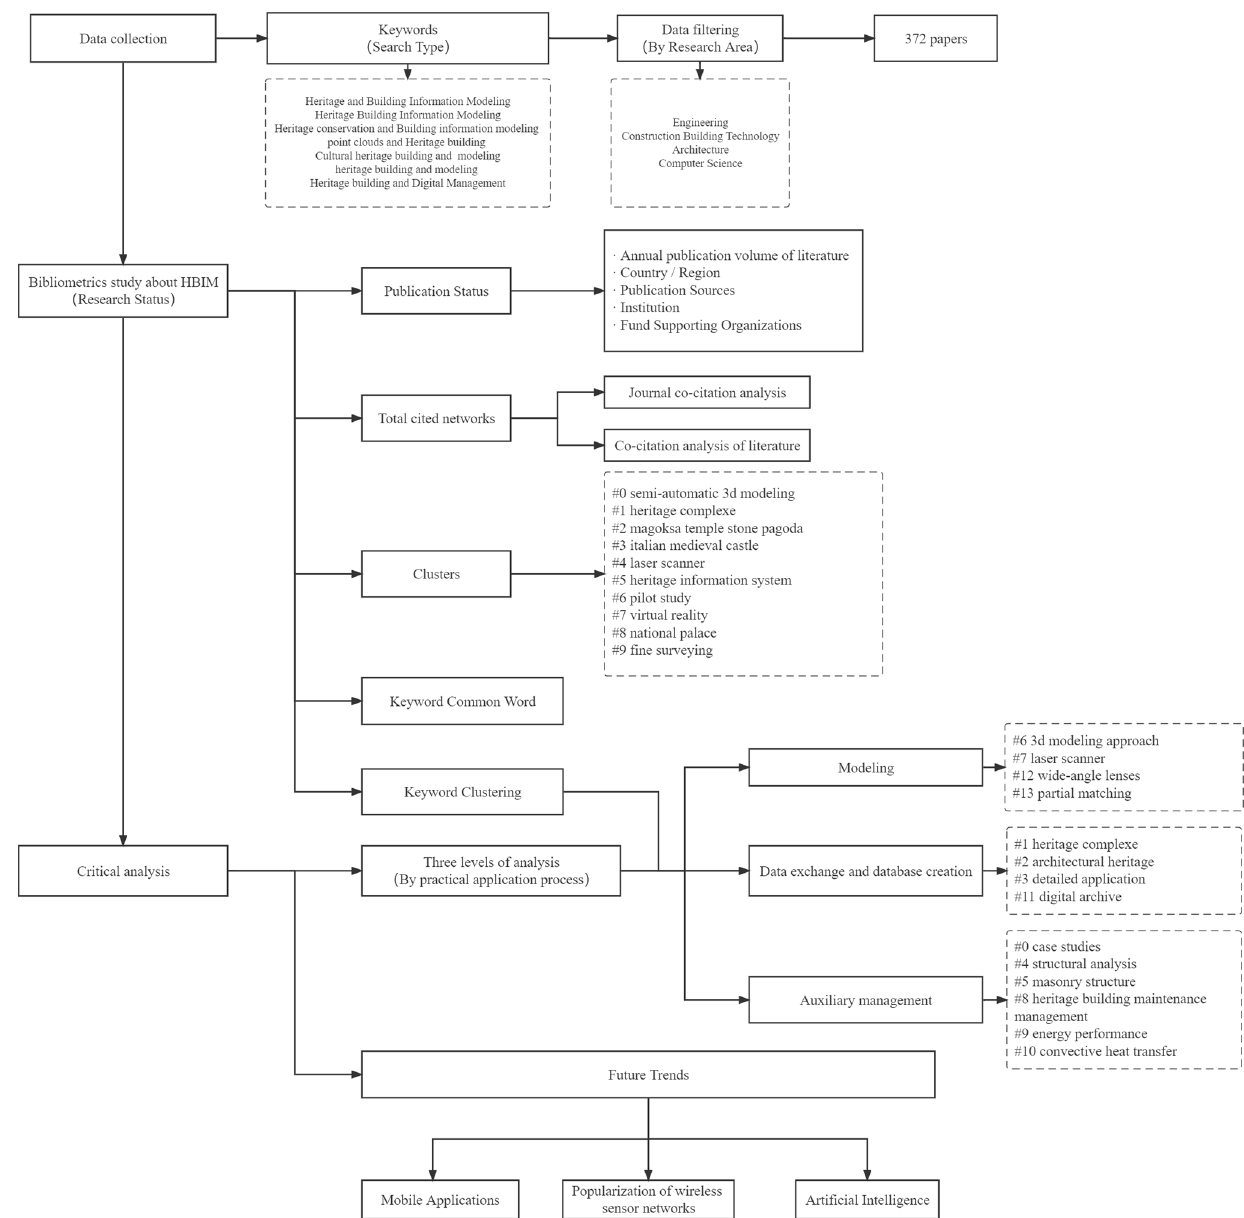
Fig. 1 Article structure diagram. The research framework of the article is presented in the form of a technology